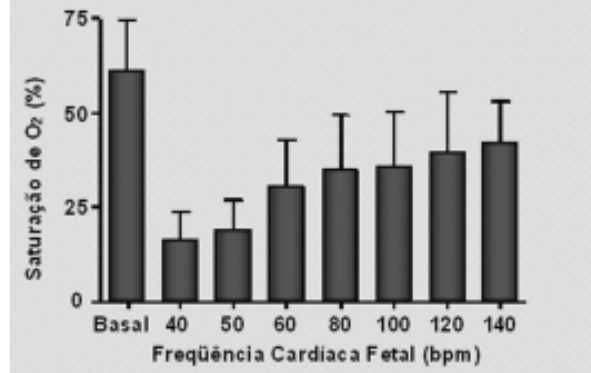
Fig. 5A - Relação da saturação de oxigênio fetal com a freqüência cardíaca fetal. n = 4, Valores = média ± desvio padrão